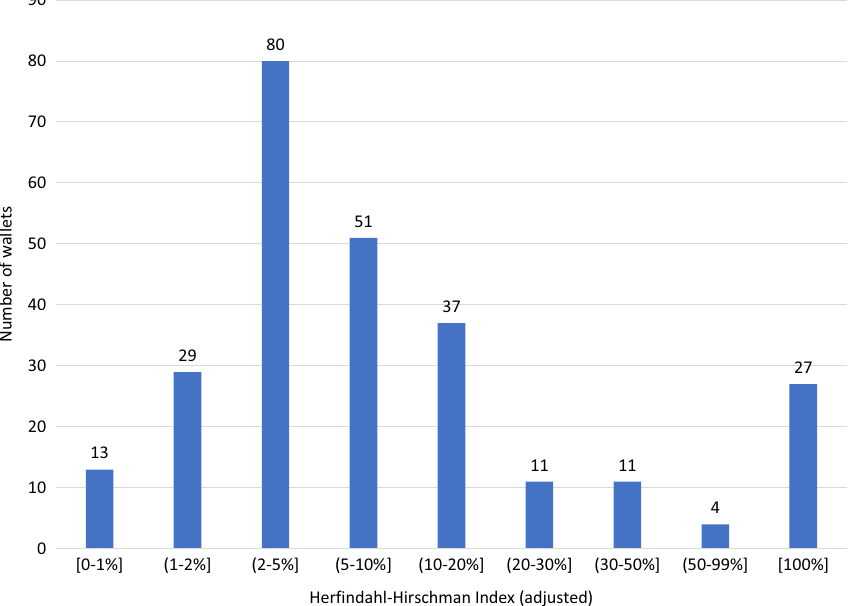
Fig. 5 Histogram of the dispersion in holdings per portfolio (invested > USD 5,000). Figure based on data from March 2021. Contains ownership of the 58 properties in Table